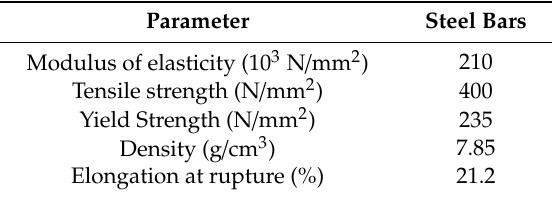
Table 4. Material Properties of steel bars from the manufacturers.